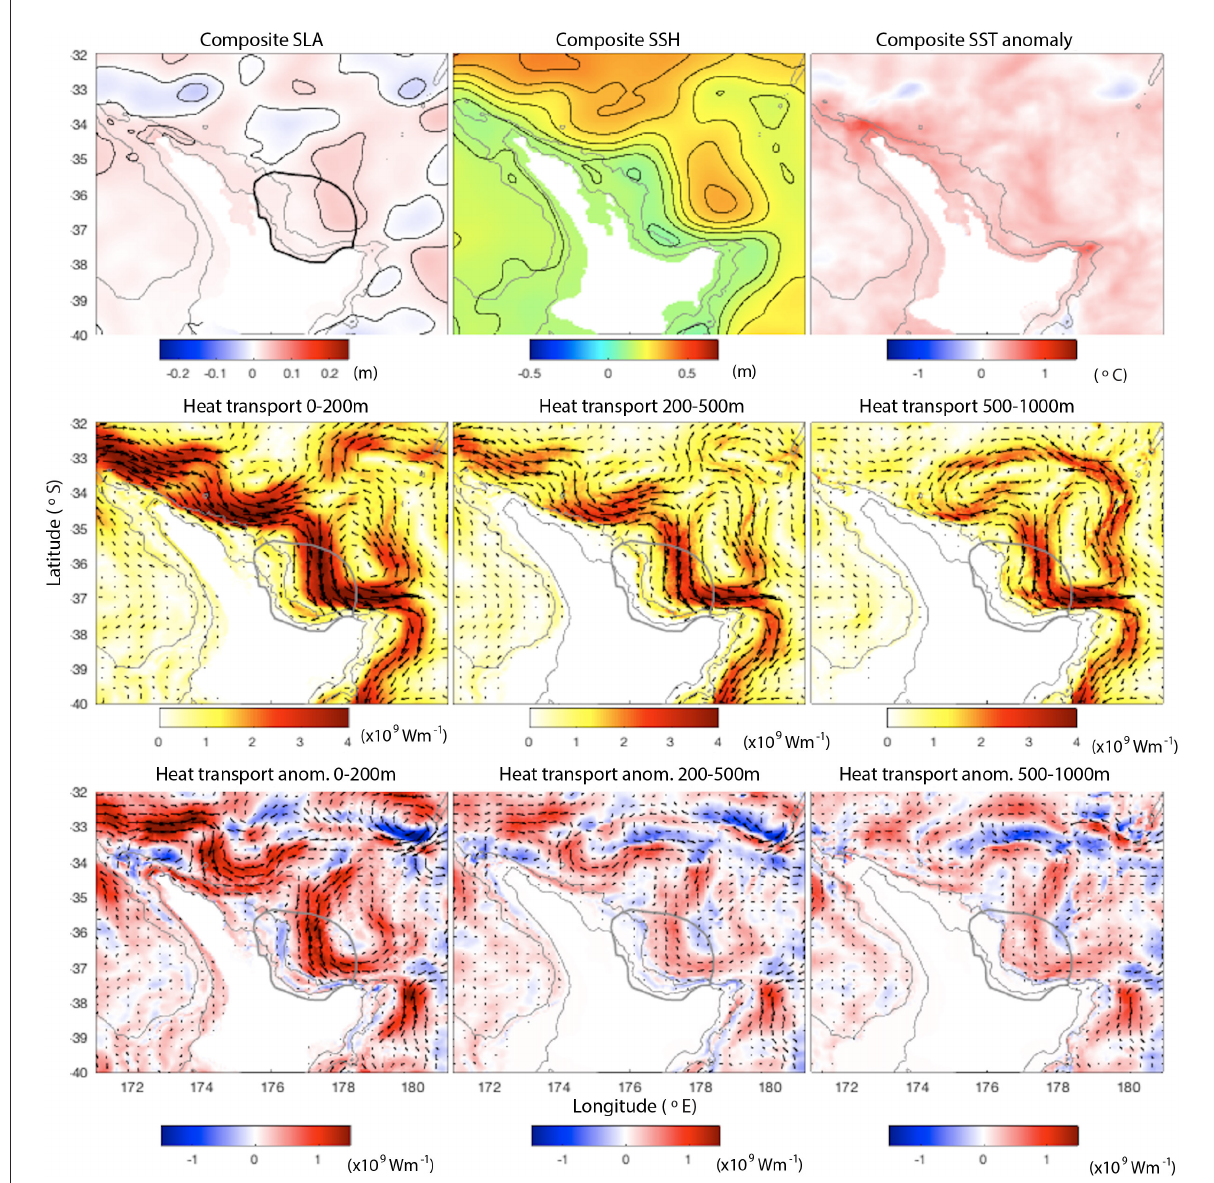
FIGURE7 (Top) : Ensemble means of SSH anomaly, SSH and SST anomaly averaged over the 4 days leading up to all 64 MHW events in the Bay of Plenty. (Middle) : Ensemble means of depth-integrated heat transport averaged over the 4 days leading up to MHW events from 0 to 200, 200 to 500, and 500 to 1,000 m (Wm − 1 ). (Bottom) : Ensemble means of depth-integrated heat transport anomalies (Wm − 1 ). Gray lines show the 100 and 1,000 m bathymetry